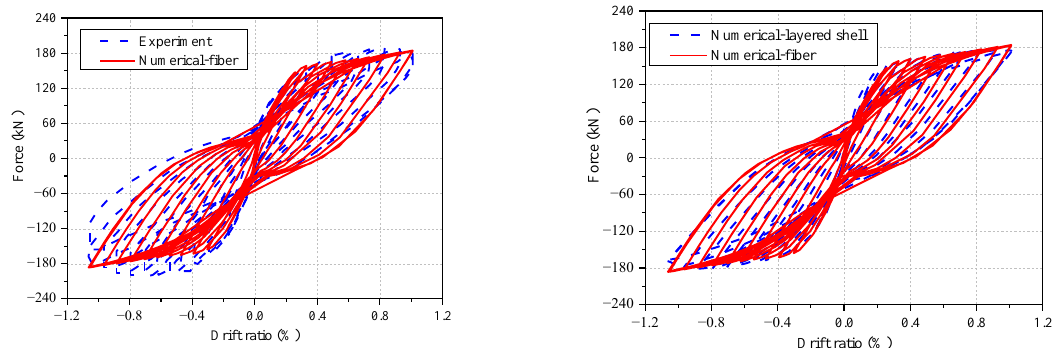
Figure 14. Hysteretic curve of the wall specimen simulated by fiber element.